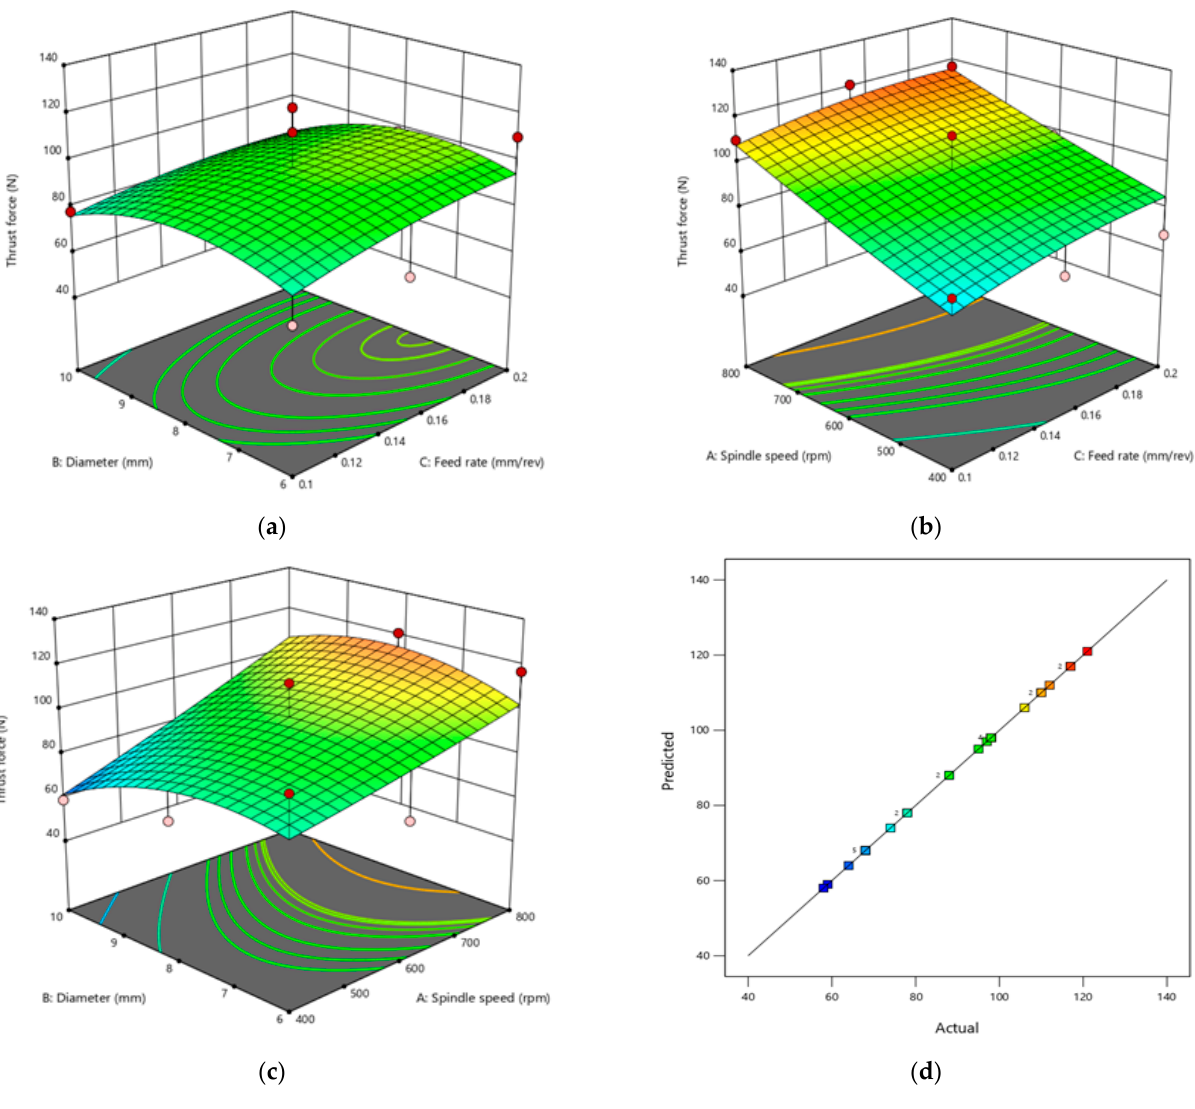
Figure 13. ( a ) The interaction between feed rate and diameter with thrust force, whereas ( b ) shows the interaction between feed and spindle speed, and ( c ) shows the interaction between spindle speed and diameter. ( d ) Actual vs. predicted thrust force.